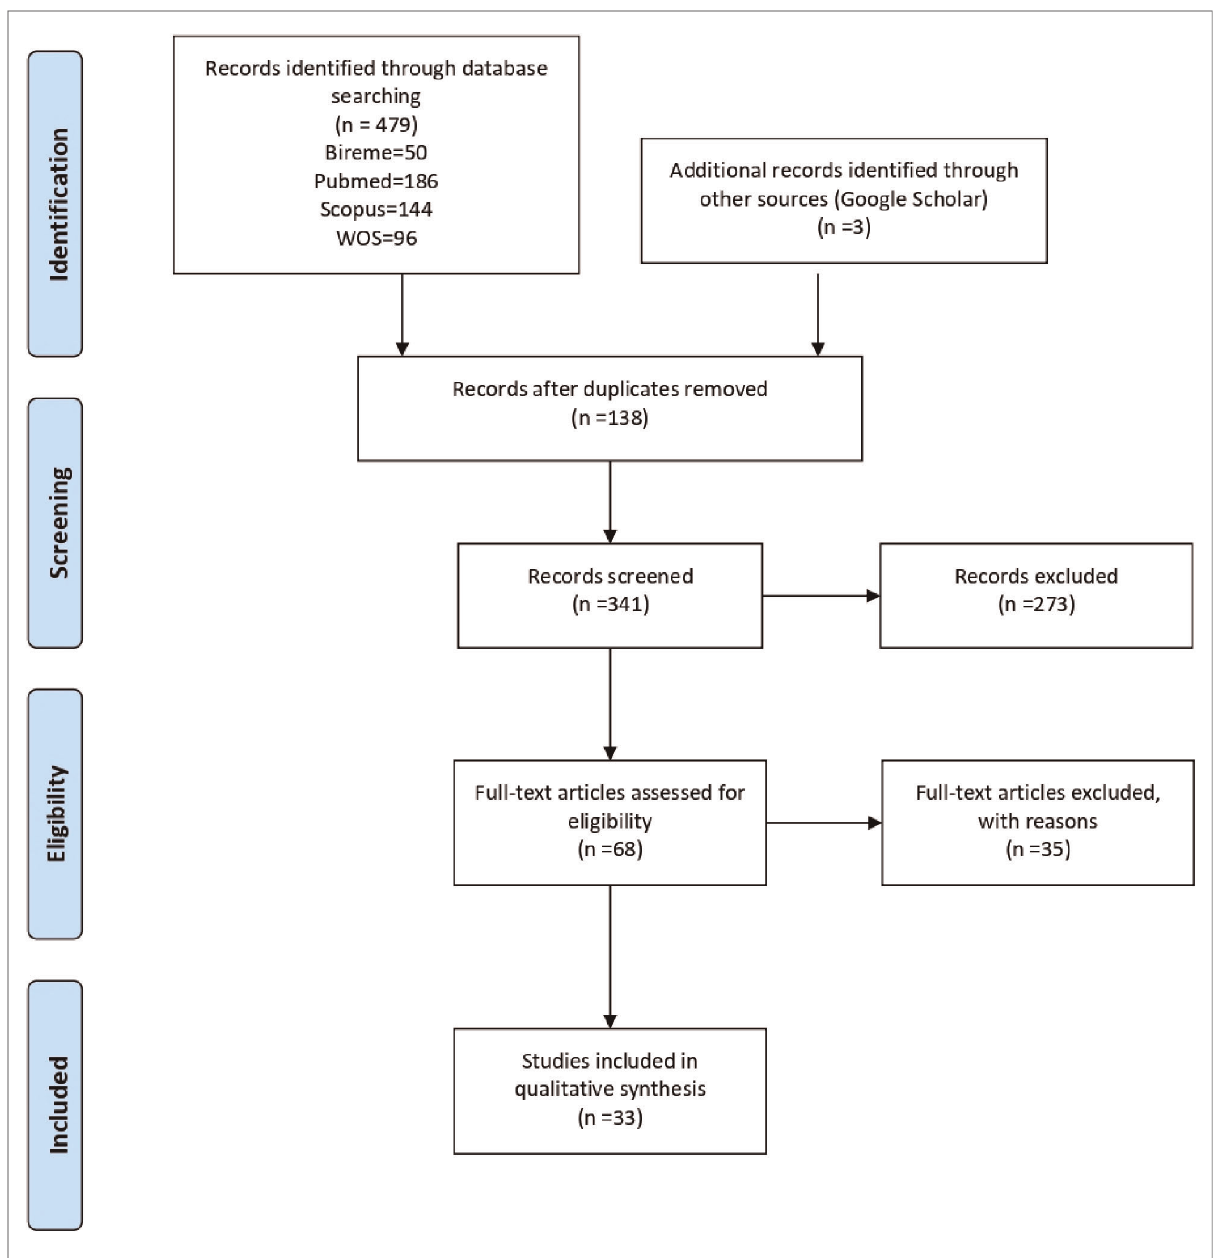
FIGURE 1 PRISMA-Scr fl